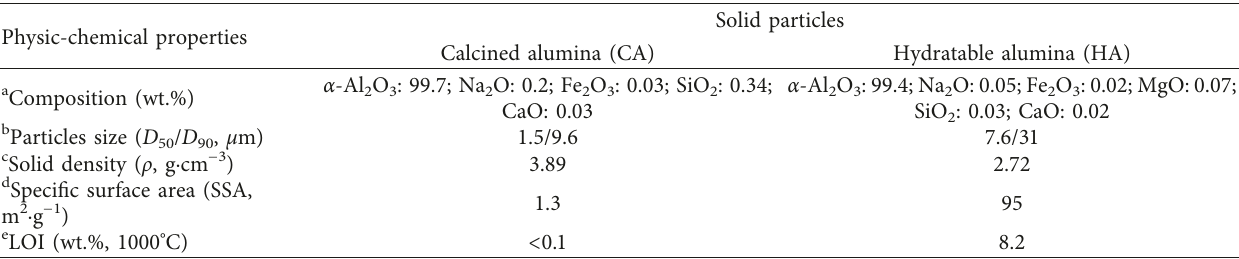
Table 1: Characteristics of the raw materials tested.